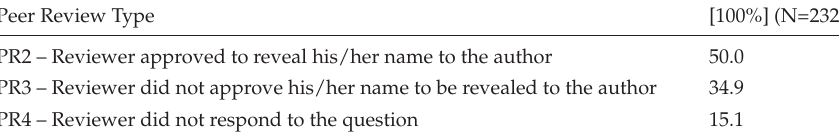
Table 7: Reviews with the option to reveal their identity or remain anonymous to the authors